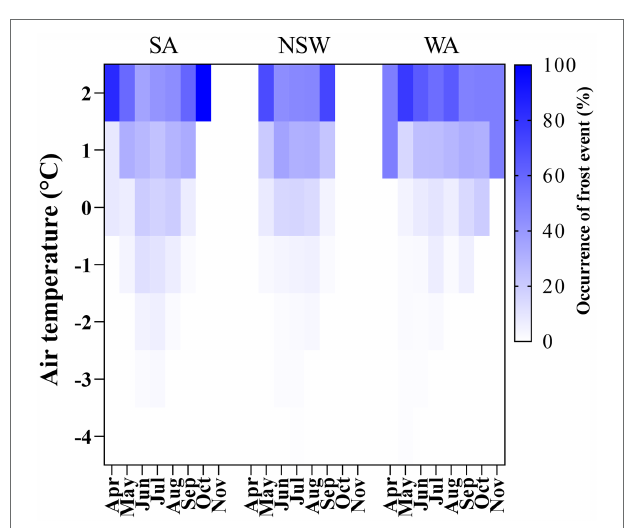
FIGURE 2 | Heat map showing the occurrence of frost events expressed as a percentage of air temperature values falling from 2 ° C to − 4 ° C from April to November across growing seasons in SA, NSW and WA